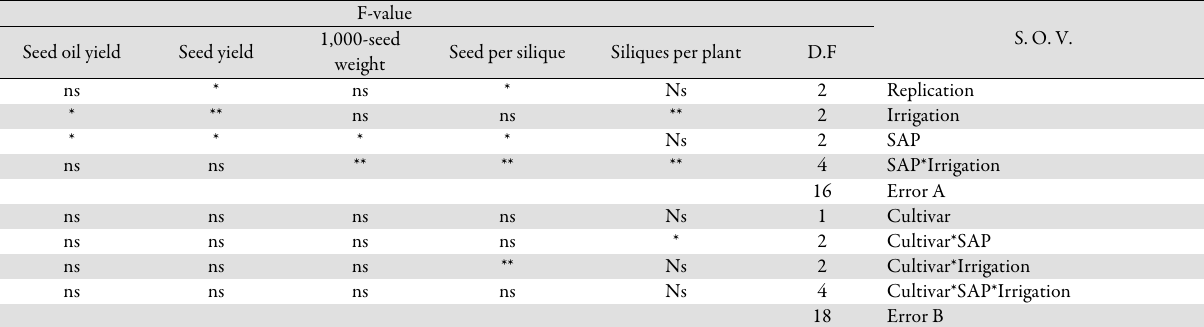
Table 2. Analysis of variance of Brassica napus seed characteristics